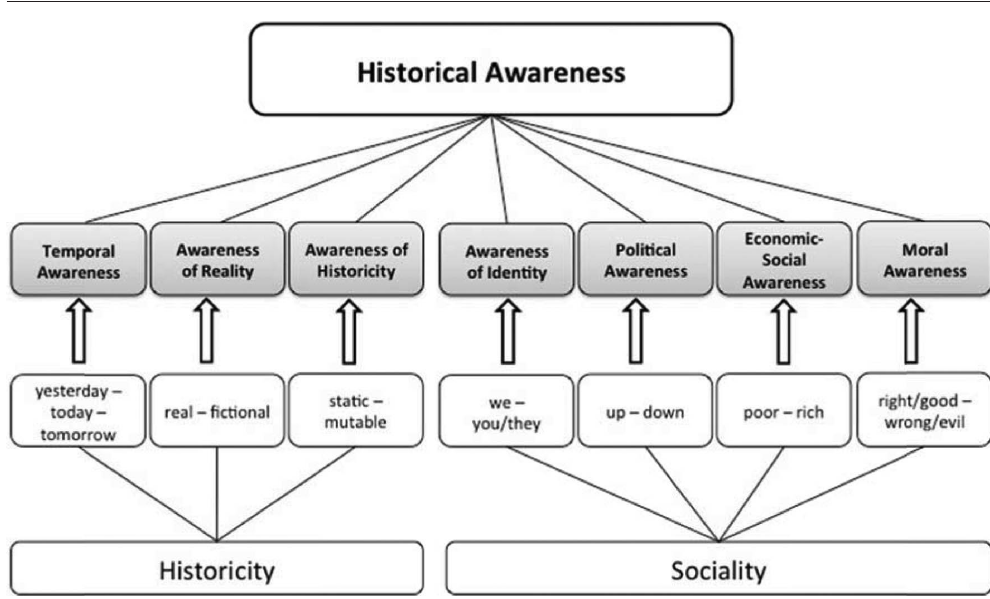
Figure 2: Pandel’s model of dimensions of historical awareness Source : von Reeken (2017: